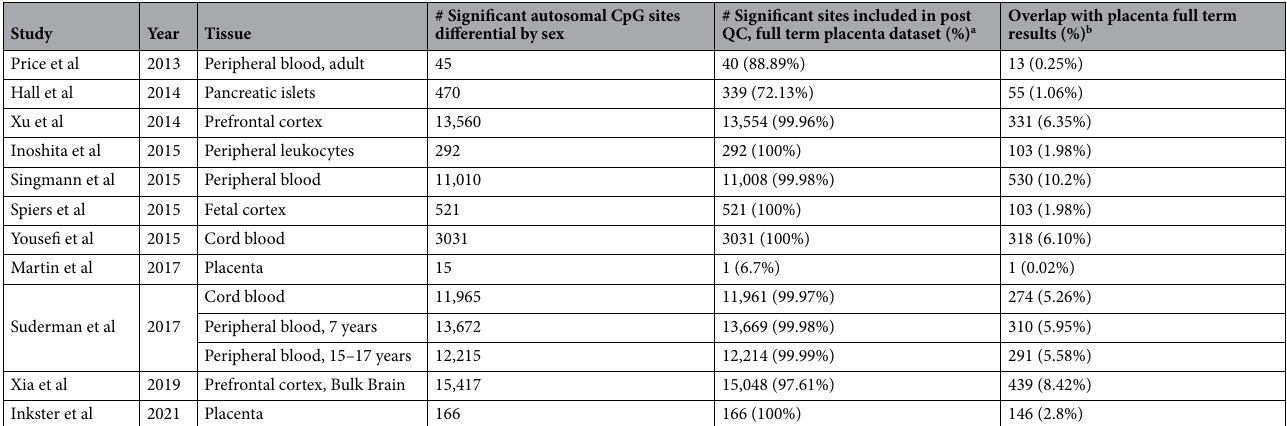
Table 2. Overlap of significant findings from previous studies of differential DNAm by sex with full term placenta results. Results from previous studies restricted to autosomes. a Percentage indicates proportion of significant sites from specified study included in placenta full term, post QC dataset. b Percentage